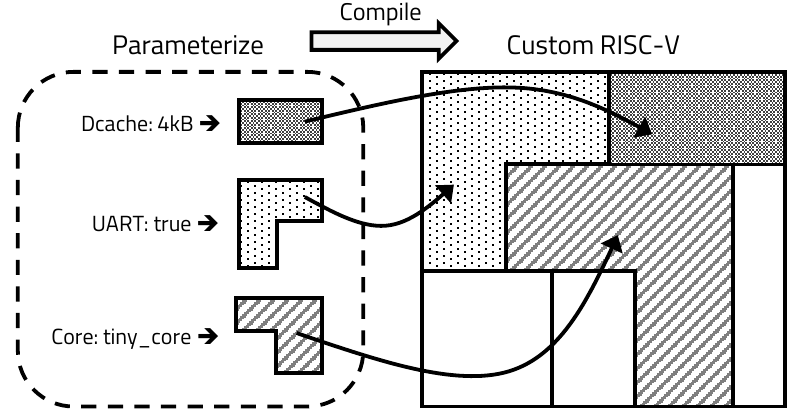
Figure 4. Processor design through hardware block parameterization using